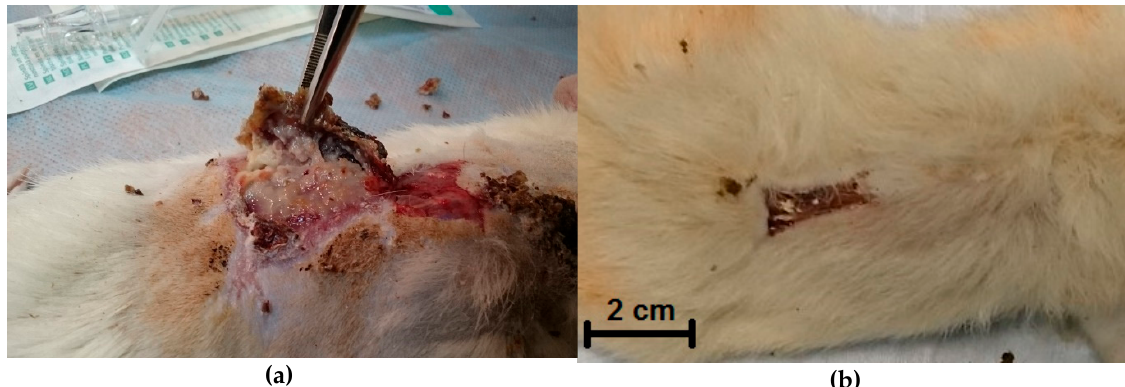
Figure 4. Visual appearance of the wound surface of an animal from the control group ( a ) and of an animal after applying the composite wound dressing ( b ) on the 28th day.